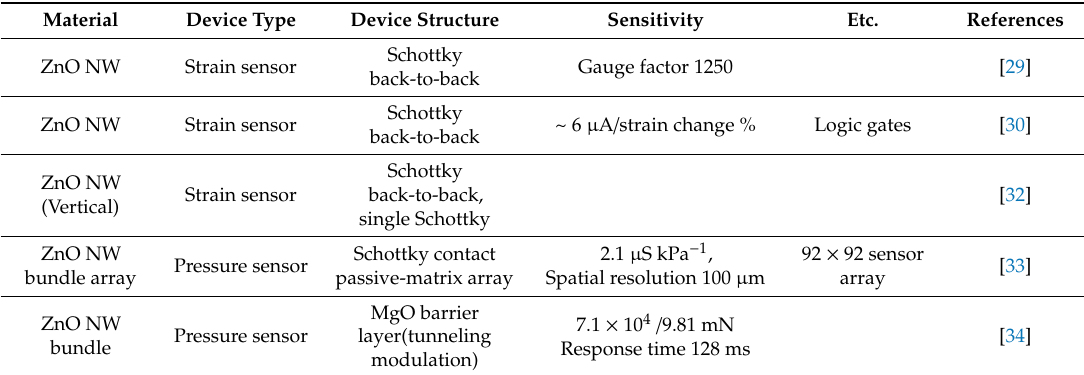
Table 5. Nanowire-based strain and pressure sensors.